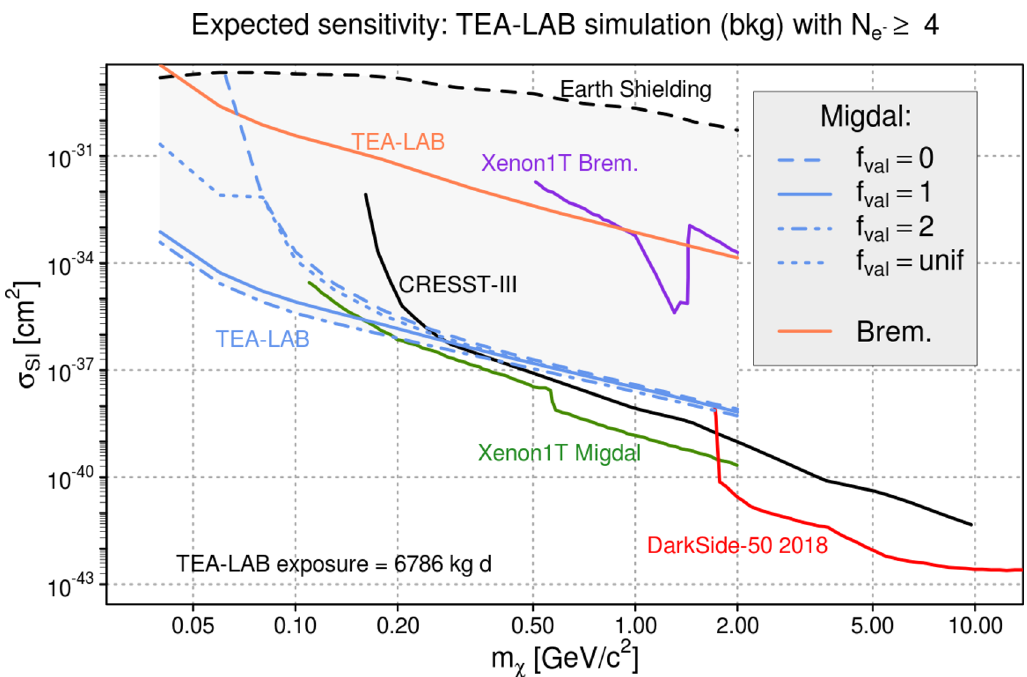
Figure 8 . 90% C : I : upper bounds on the (cid:27) SI exploiting the Migdal electron and photon Bremsstrahlung signals for the tea-lab simulated experiment loosely inspired by DarkSide-50. These results are obtained using and exposure E = 6786 kg d , and simulating a pseudo-dataset with the background-only template, not including the LowNe excess (see section 3.2, 3.1). The tea-lab bounds are computed for a threshold N = 4 . Different Migdal electron signal uncer- e (cid:0) tainties are considered (see section 3.2.2): f val = 0 corresponding to no valence shell contribution (blue dashed line), f val = 1 (blue line), f val = 2 (dashed-dotted line), and f val treated as a nuisance parameter with a uniform prior p.d.f. in [0 ; 2] (dotted blue line). The tea-lab bound for the pho- ton Bremsstrahlung signal is reported (orange line). The estimate of the Earth shielding effect for tea-lab is also reported (black dashed curve). The gray shaded area, has to be intended as the region where tea-lab has the sensitivity to exclude a DM signal exploiting the Migdal